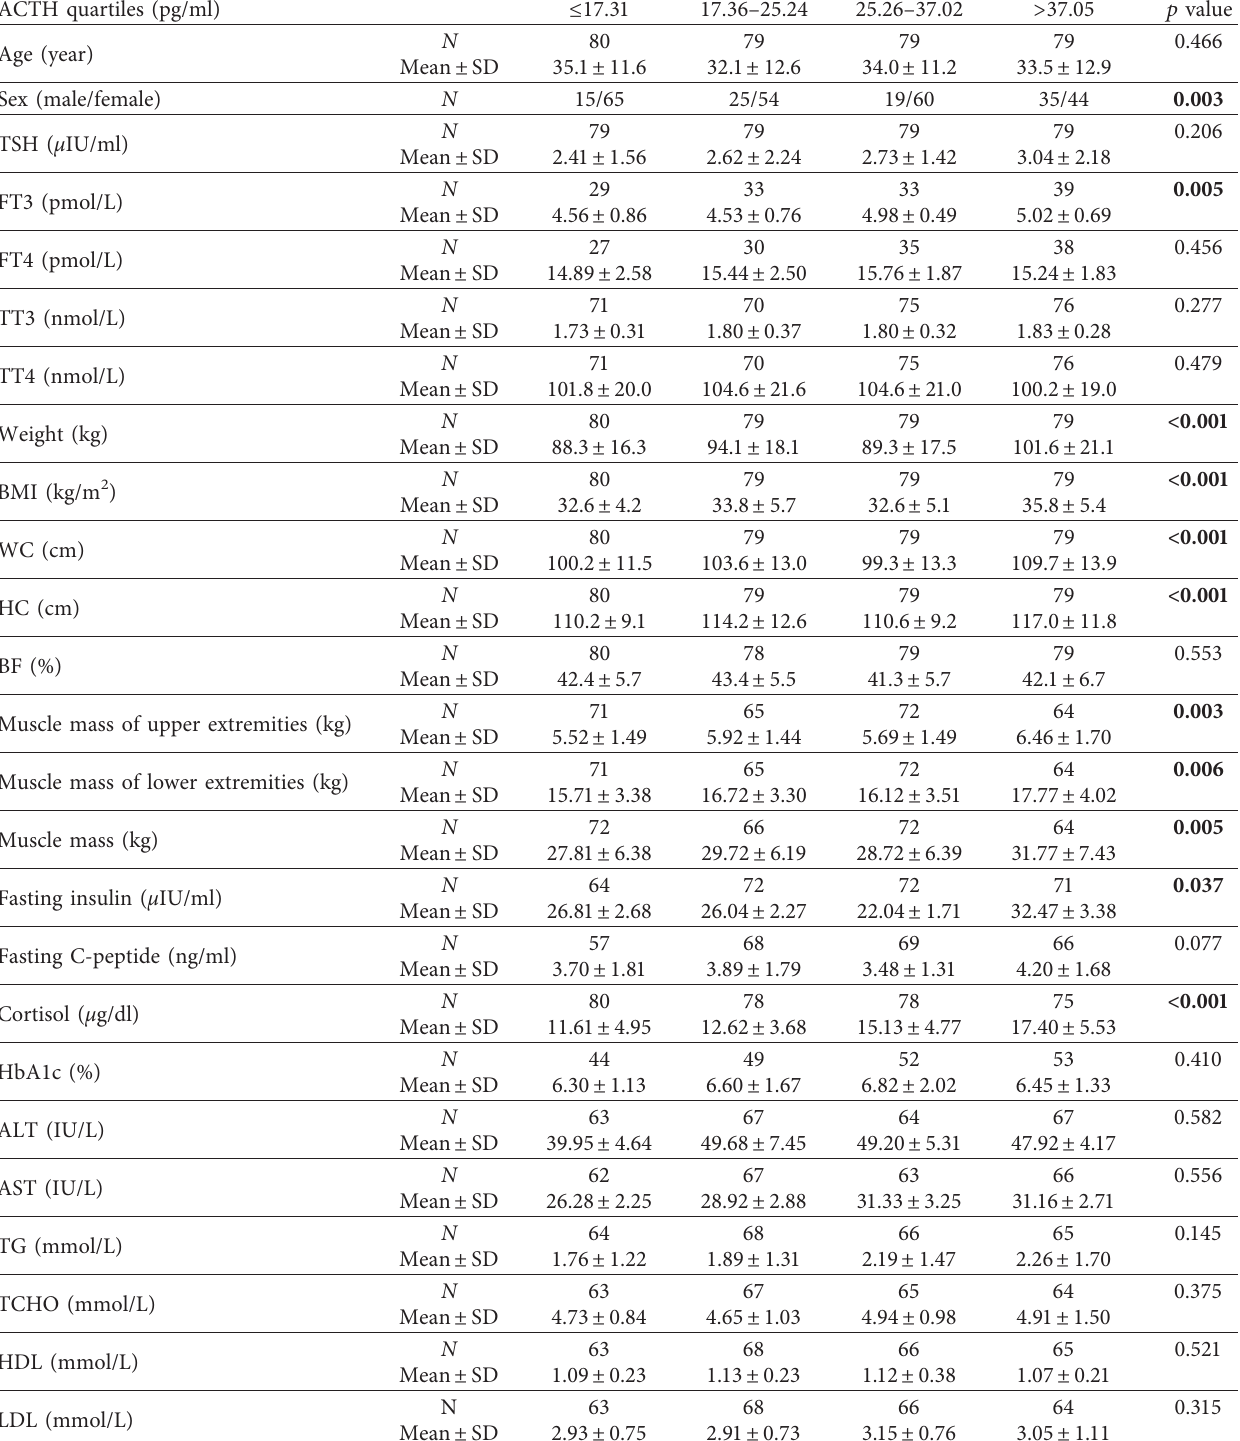
Table 4: The distribution of demographic data and metabolic indicators across the ACTH quartiles in overweight or obese individuals. ACTH quartiles